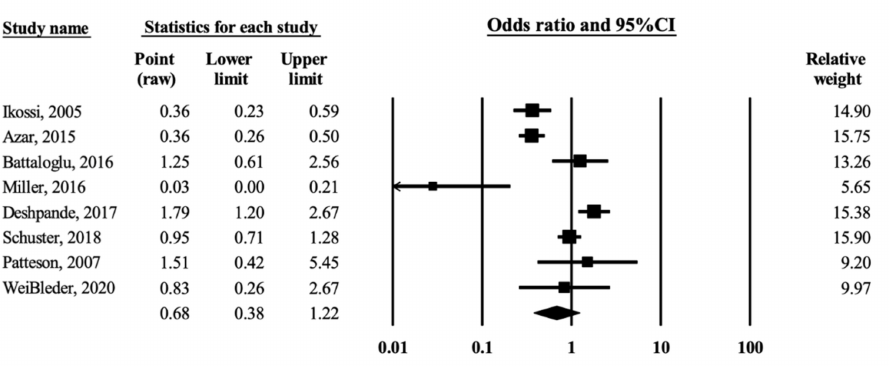
Figure 2. Forest plot of odds ratio for mortality from motor vehicle crashes in association with pregnancy [5–9,11,17,18]. The black squares represent the odds ratios of the individual studies and the horizontal lines are their 95% CI. The area of the black squares and diamond respectively reflects the weight each trial contributes and the overall effect from the meta-analysis.